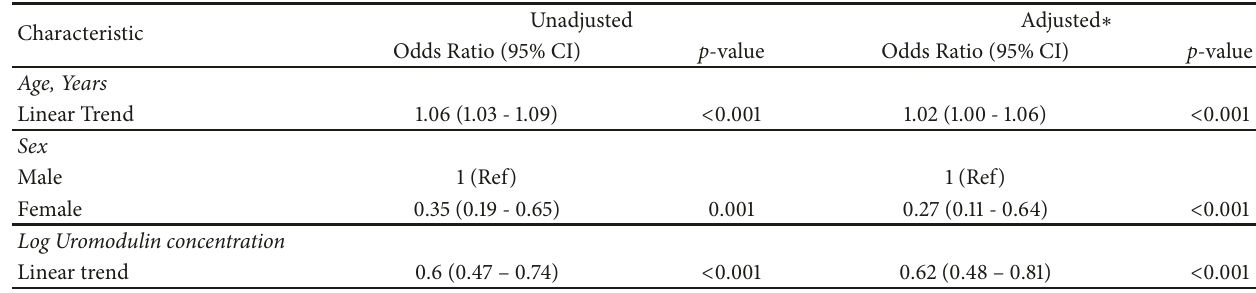
Table 2: Association with hypertension-attributed chronic kidney disease.